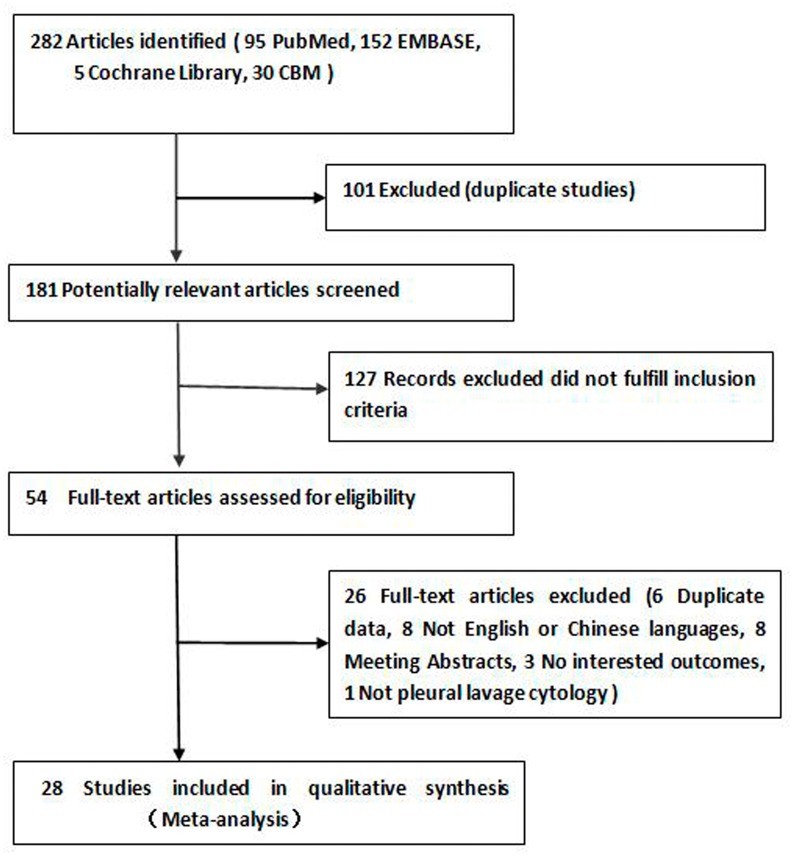
Selection process for the meta-analysis.